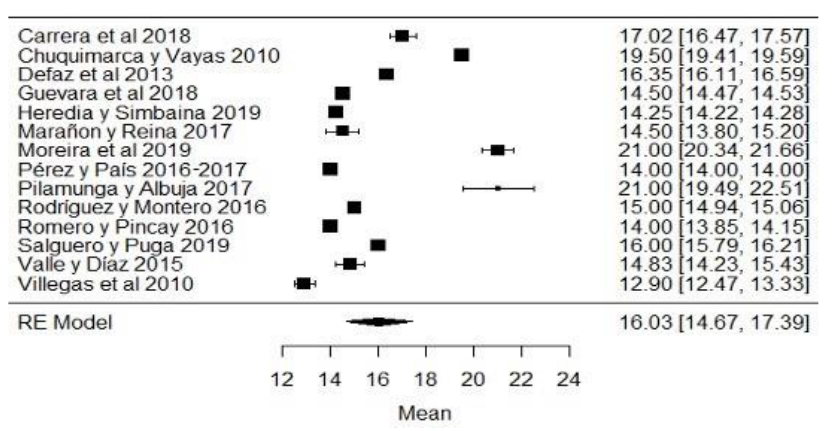
Figure 2. Forest plot of titratable acidity by study